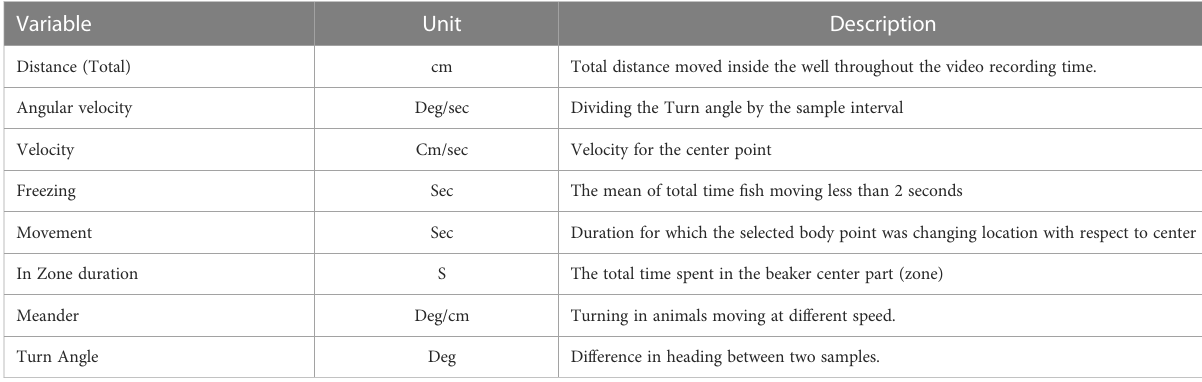
TABLE 1 Behavioral variables from Noldus ethovision software used in this study to analyze Mysid shrimp ( A. bahia ) larvae and Silverside ( M. beryllina ) larvae behavioral response.